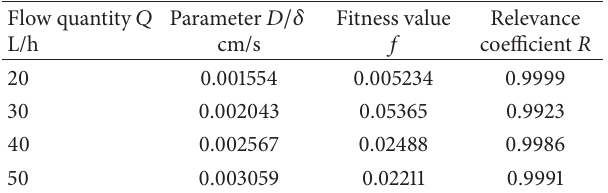
Table 4: Particle swarm optimization algorithm inversion